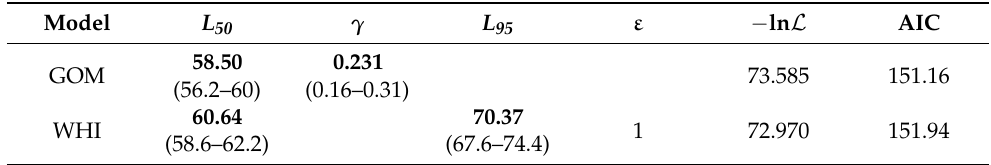
Figure 4. Monthly proportions of immature (dark gray bars) and mature (light gray bars) females of Narcine entemedor throughout the study period ( n = 214). The sample size is denoted above each bar. Table 3. Parameters (in bold) and confidence intervals (in parenthesis) estimated from negative ln-likelihood contours ( p < 0.05). L 50 is the length at which 50% of the organisms were mature, L 95 is the length at which 95% of the organisms are